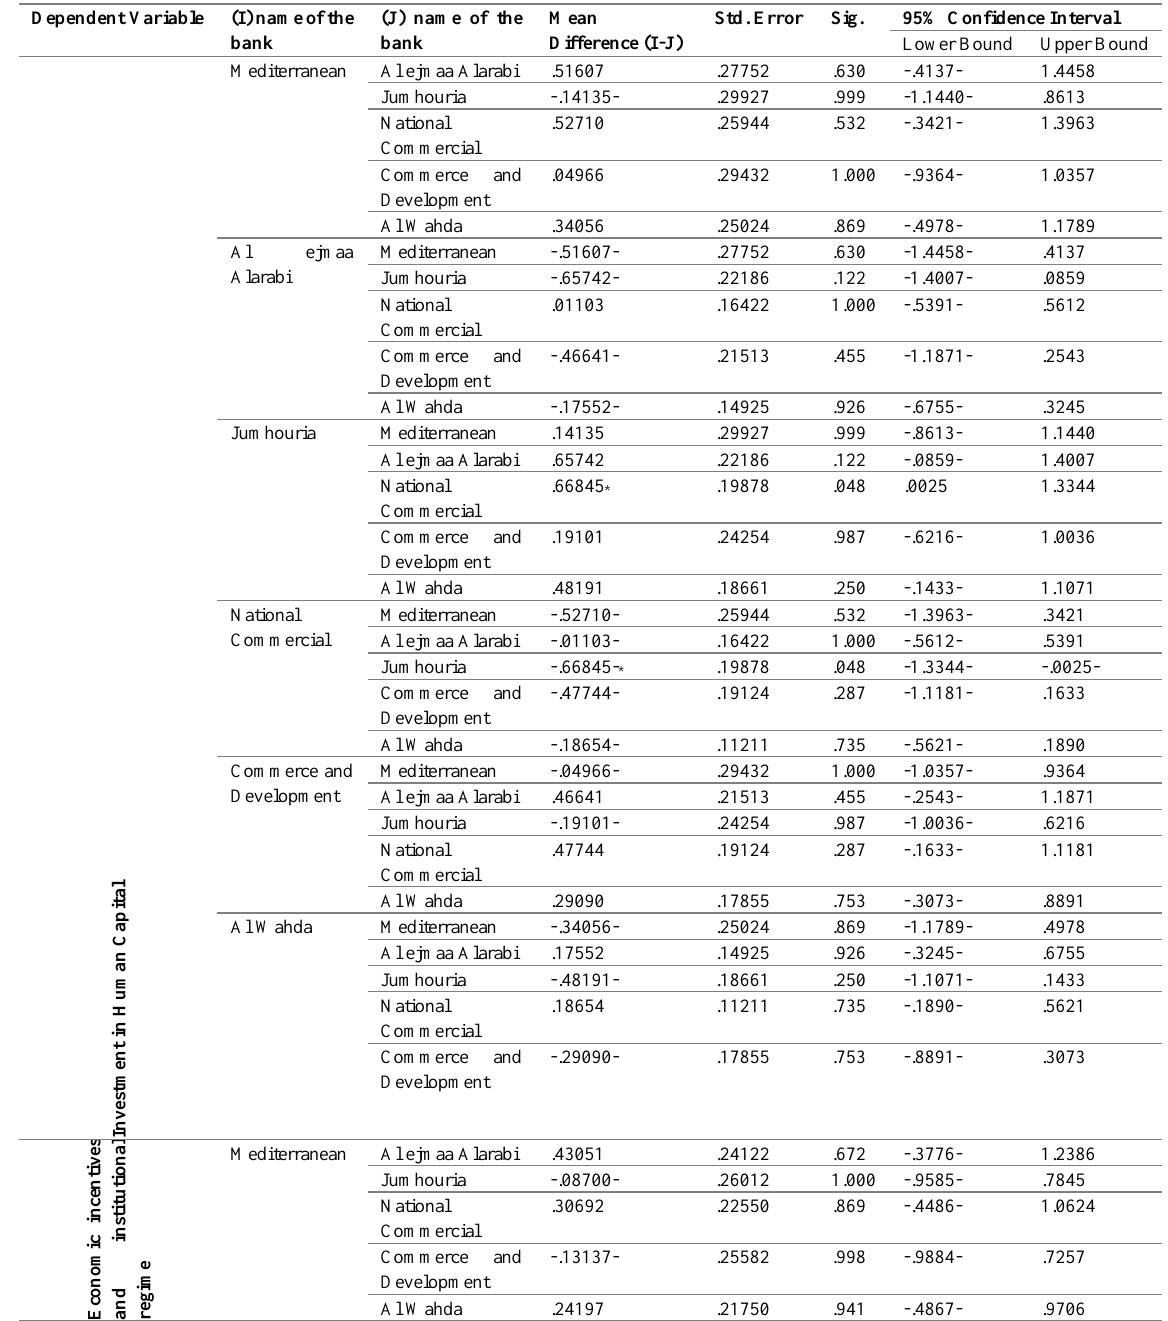
Table 11: Multiple Comparisons (Scheffe